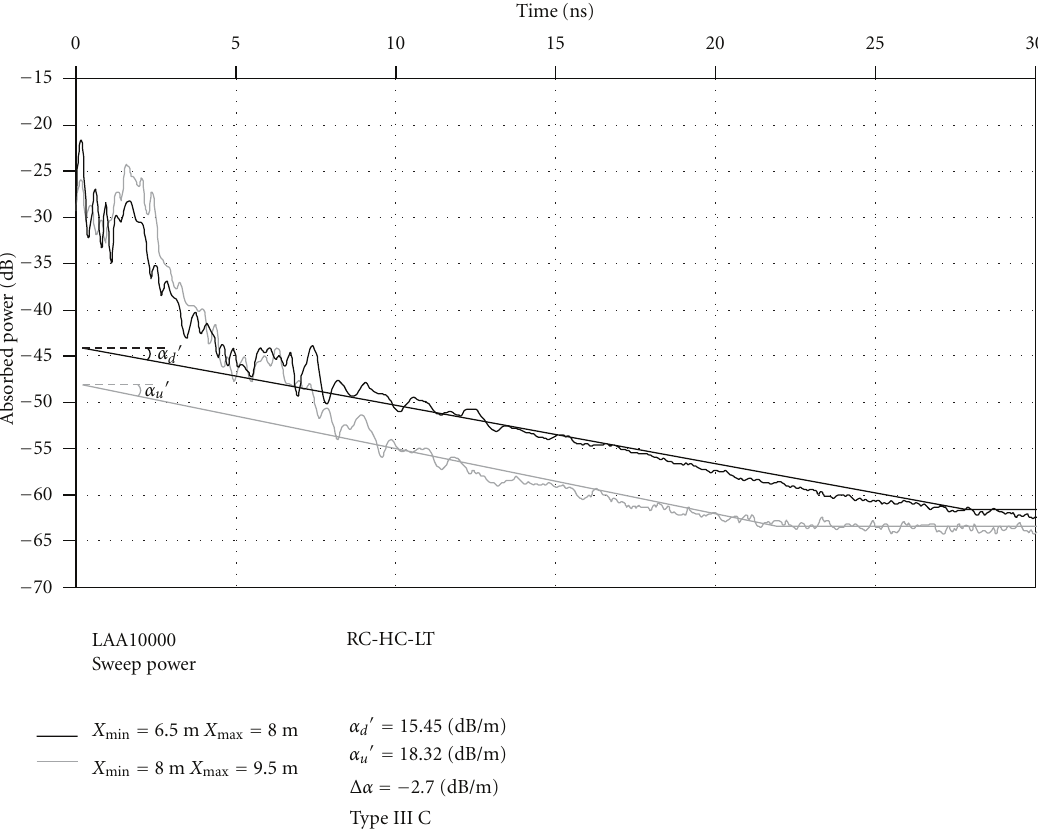
Figure 11: Power diagram (case Δ α <